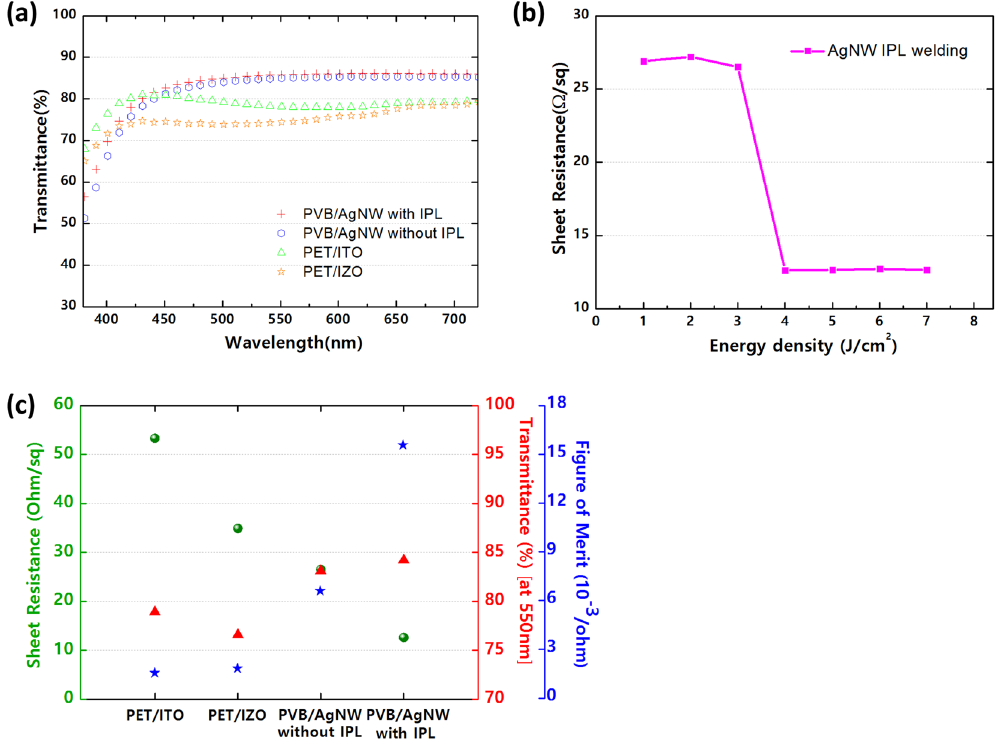
Figure 3. ( a ) Transmittance spectrum of IPL-treated and non-treated pristine PVB/AgNWs, PET/ITO, and PET/IZO films. ( b ) Sheet resistance response to the intense pulsed light method induced welding. ( c ) Figure of merit values for relative sheet resistance and transmittance values of the PET/ITO, PET/IZO, and PVB/AgNWs films with and without IPL.